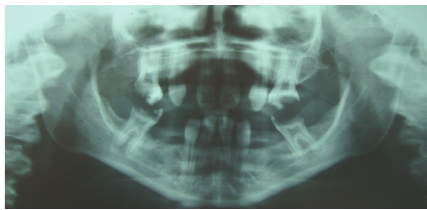
Figure 4: Oligodontia is clearly observed on panoramic radiograph.